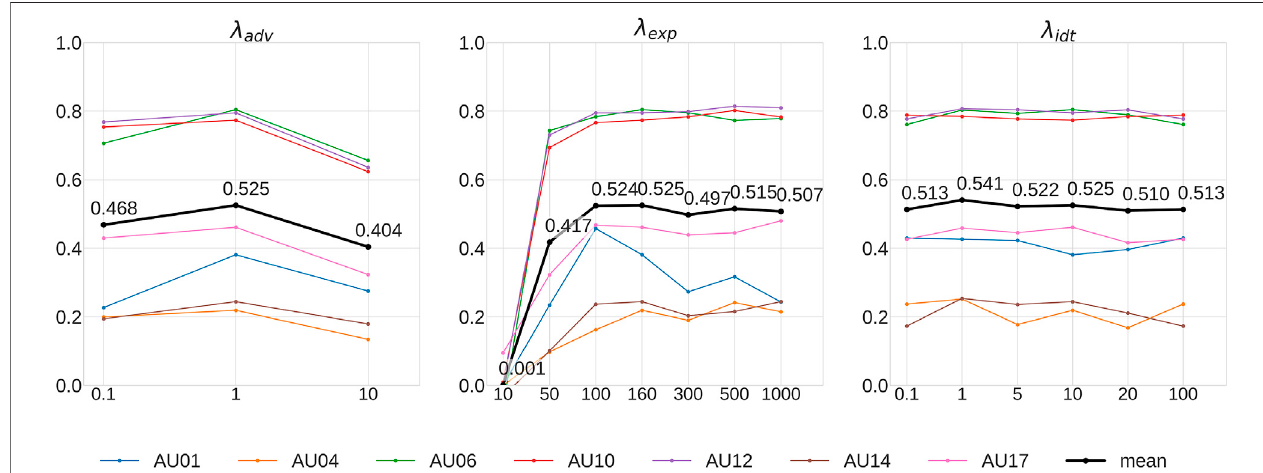
FIGURE 3 | In fl uence of parameter values on ICC for intensity estimation.